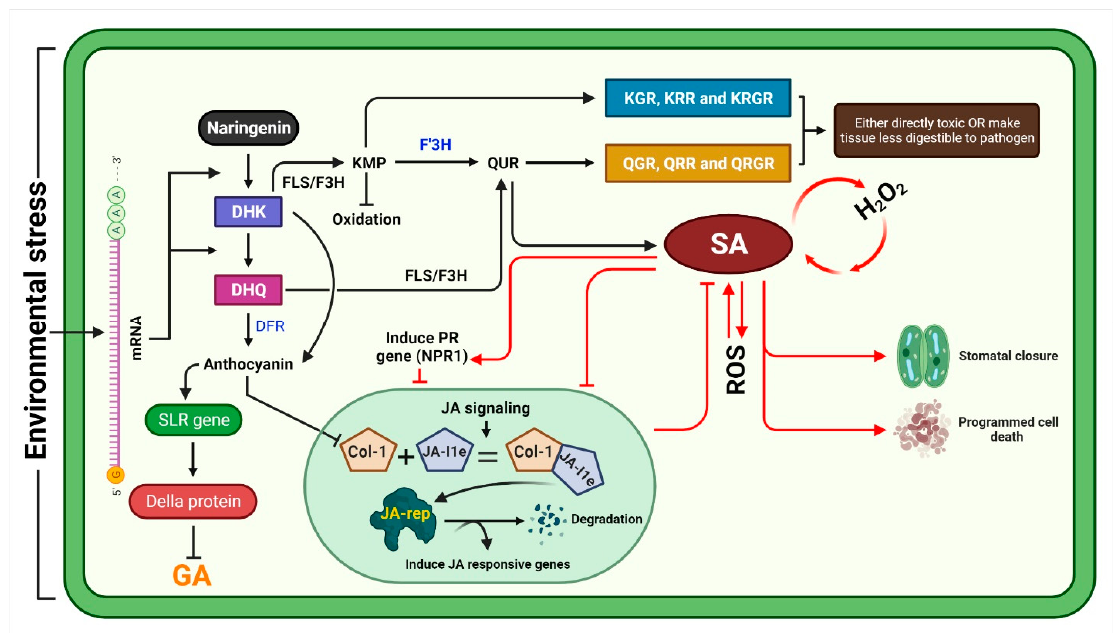
Figure 2. Proposed flow chart of the regulation of plant defence system mediated via kaempferol and quercetin under stress condition. The figure is adopted from our previously published article [50]. DHK (dihydrokaempferol), DHQ (dihydroquercetin), DFR (dihydroflavonol 4- reductase), FLS (flavonol synthase), F3H (flavanone 3-hydroxylase), KMP (kaempferol), QUR (quercetin), QGR (quercetin 3-O- glucoside 7-O -rhamnoside), QRR (quercetin 3-O -rhamnoside 7-O -rhamnoside), QRGR (quercetin 3-O -[ 6 ″ -O -(rhamnosyl) glucoside] 7-O -rhamnoside), SLR (slender rice mutant), GA (gibberellic acid), JA (jasmonic acid), Col-1 (collagen type I), JA-l1e (Jasmonic Acid-Isoleucine), PR (pathogenesis related), NPR (nonexpressor pathogenesis-related), KGR (kaempferol 3-O glucoside 7-O rhamnoside), KRR (kaempferol-3,7-dirhamnoside), KRGR (kaempferol 3-O- [ 6 ″ -O -(rhamnosyl) glucoside] 7-O rhamnoside), SA (salicylic acid), and ROS (reactive oxygen specie).